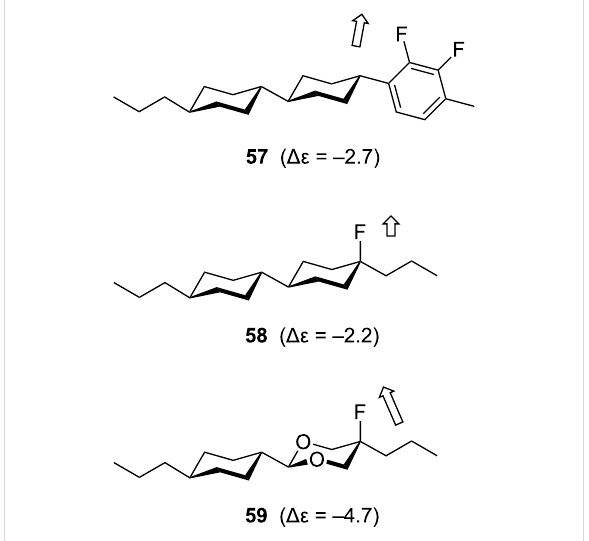
Figure 14: Examples of fluorinated liquid crystal molecules. Arrows in- dicate the orientation of the molecular dipole moments, which are quantified in the negative dielectric anisotropy values, Δε